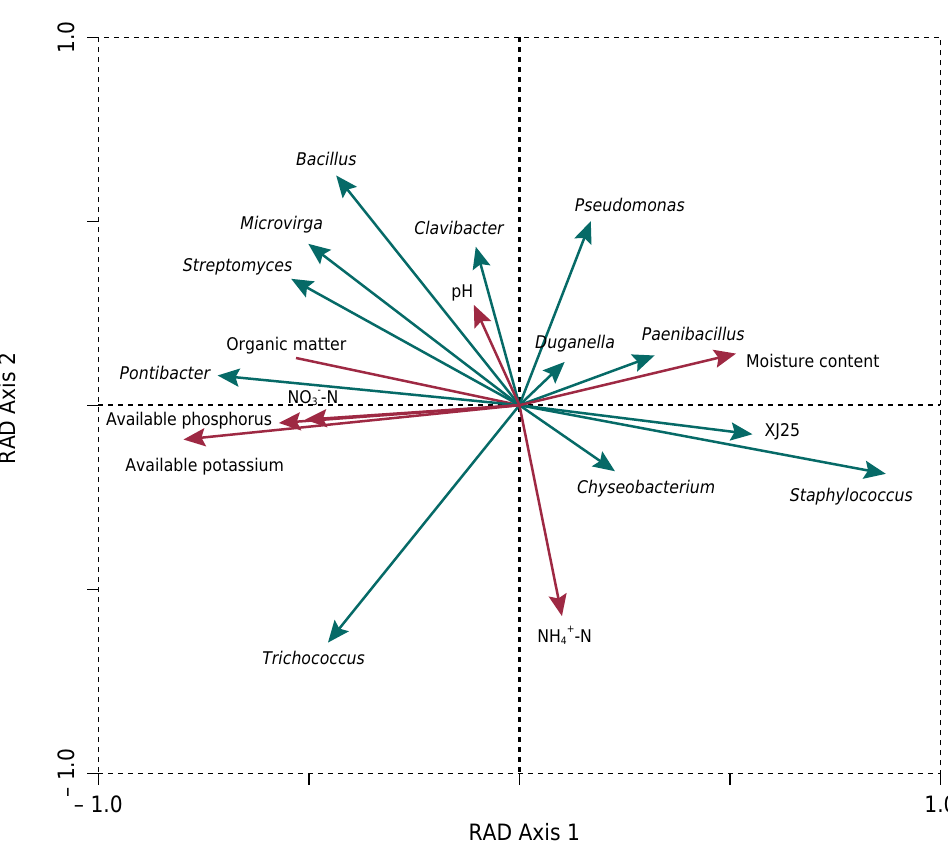
Figure 3. Redundancy discriminate analysis (RDA) plots of the relative abundance of bacterial genera and soil properties. Soil properties included available potassium, available phosphorus, moisture content, NO 3- -N, organic matter, NH 4 + -N, and pH (dashed arrows). Bacterial genera included Bacillus, Trichococcus, Paenibacillus, Microvirga, Pseudomonas, Duganella, Chryseobacterium, Pontibacter, Staphylococcus, Clavibacter, Streptomyces , and XJ25 (solid arrows, italics). Bacteria and soil properties were obtained from the 0.00-0.30 m soil layer. Eigenvalues (0.477 for horizontal axis, 0.201 for vertical axis) along the axes indicate the amount of variability explained in the relative abundance of bacterial